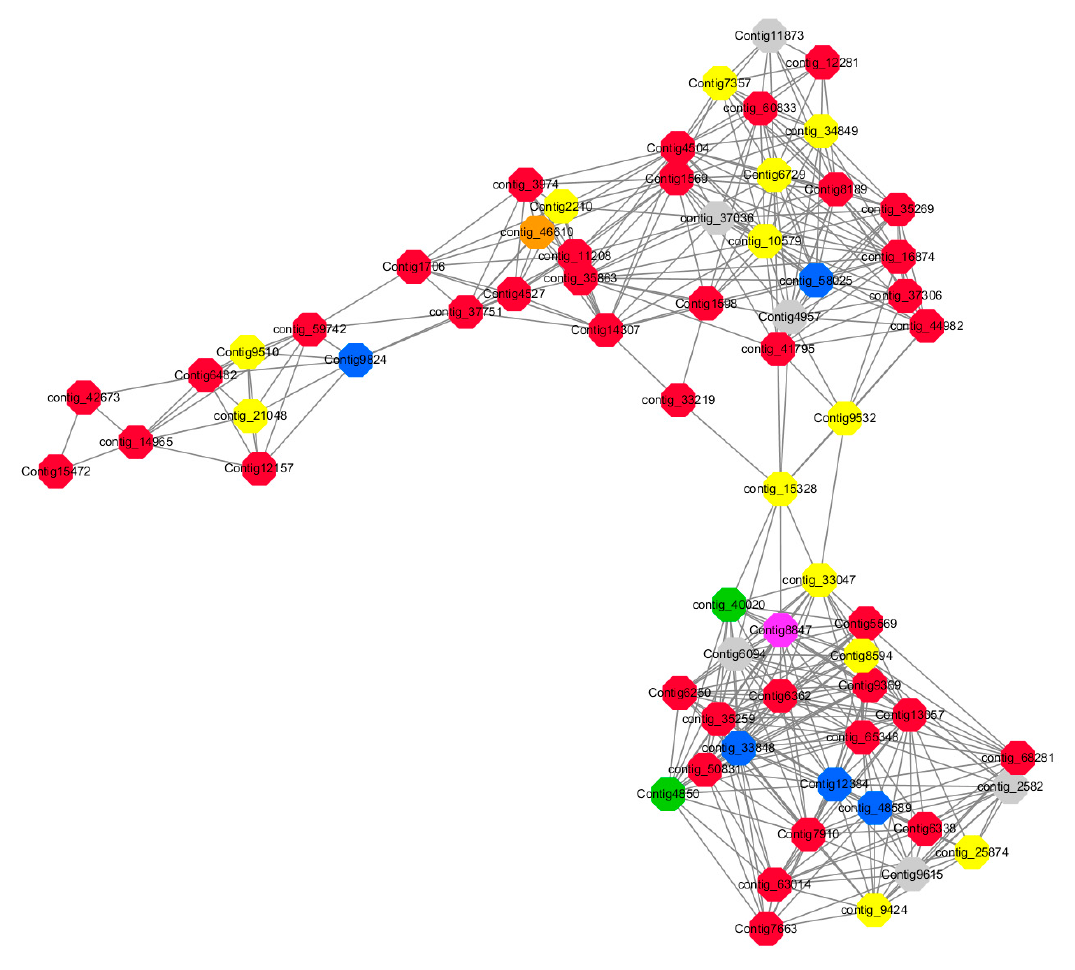
Figure 15. GCN of Module 2.